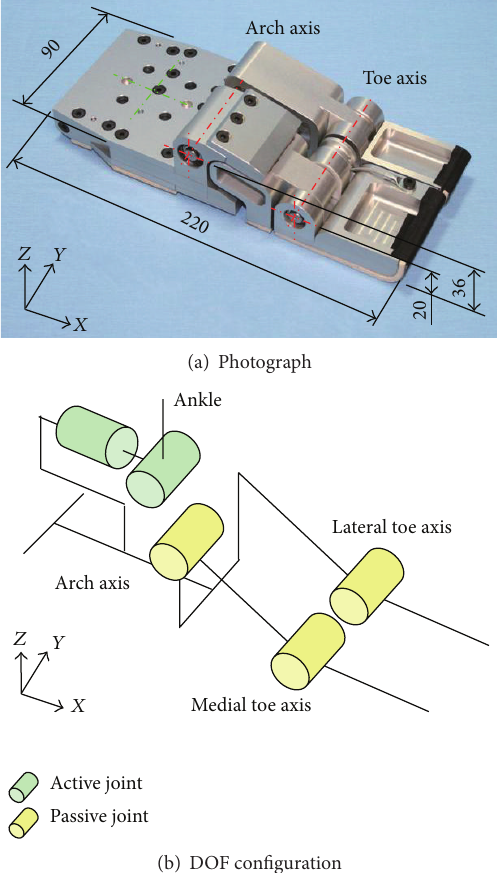
Figure 2: Human-like foot mechanism with the medial longitudinal